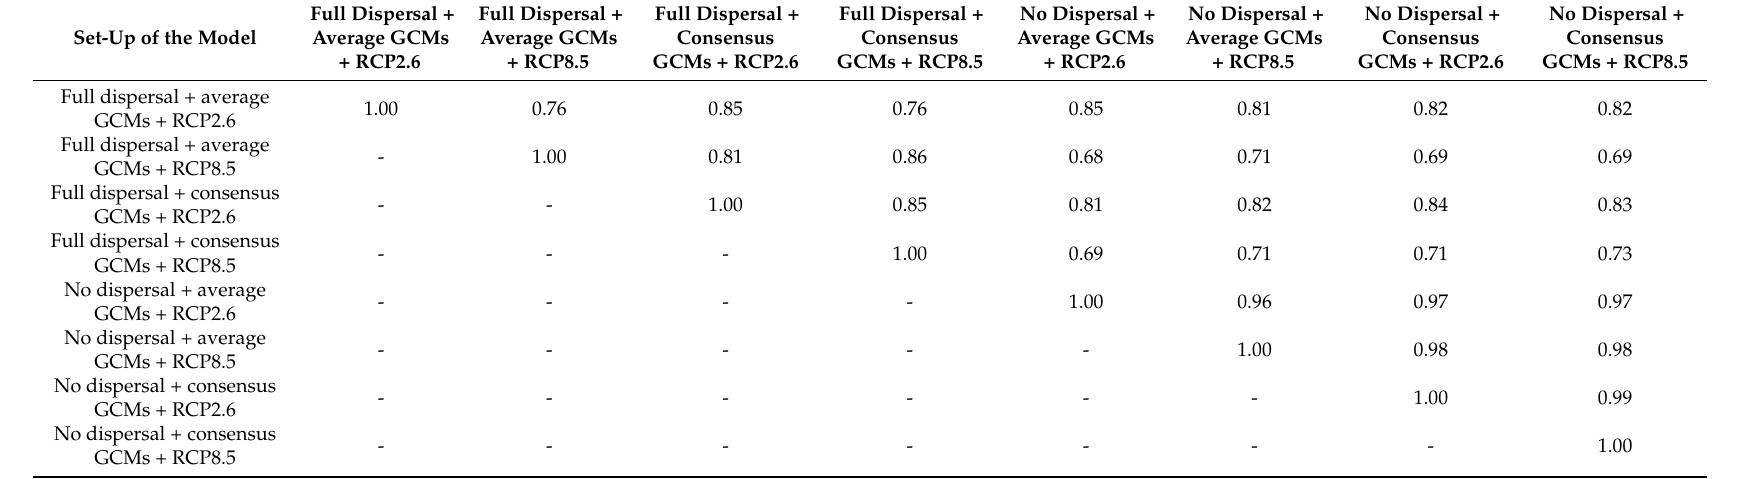
Table 3. Values of Kappa coefficients between different projection maps of future potential distribution of Sapindus mukorossi in China.